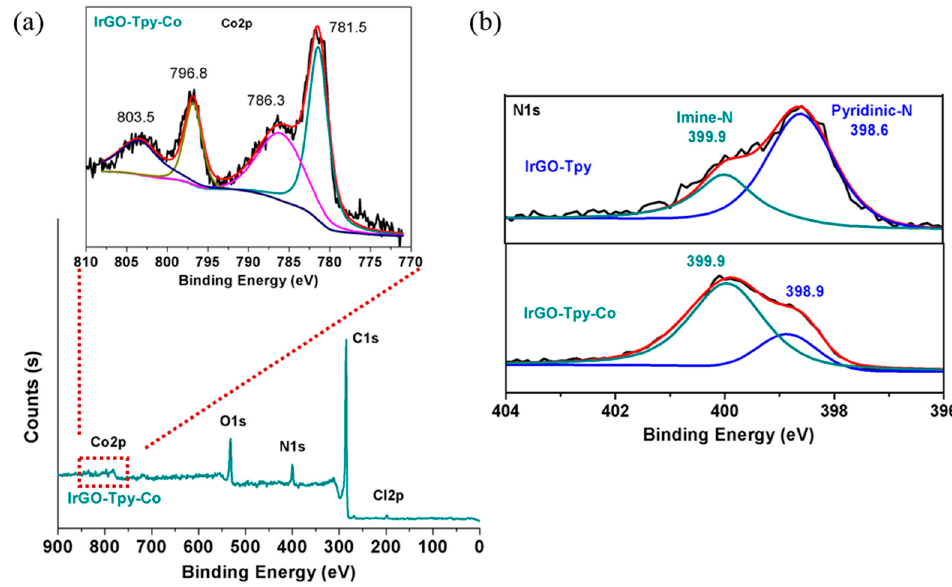
Figure 4. ( a ) XPS survey spectrum of IrGO ‐ Tpy ‐ Co, (inset) high ‐ resolution Co 2p XPS spectrum of IrGo ‐ Tpy ‐ Co, and ( b ) N 1s XPS spectra of IrGO ‐ Tpy (upper) and IrGO ‐ Tpy ‐ Co